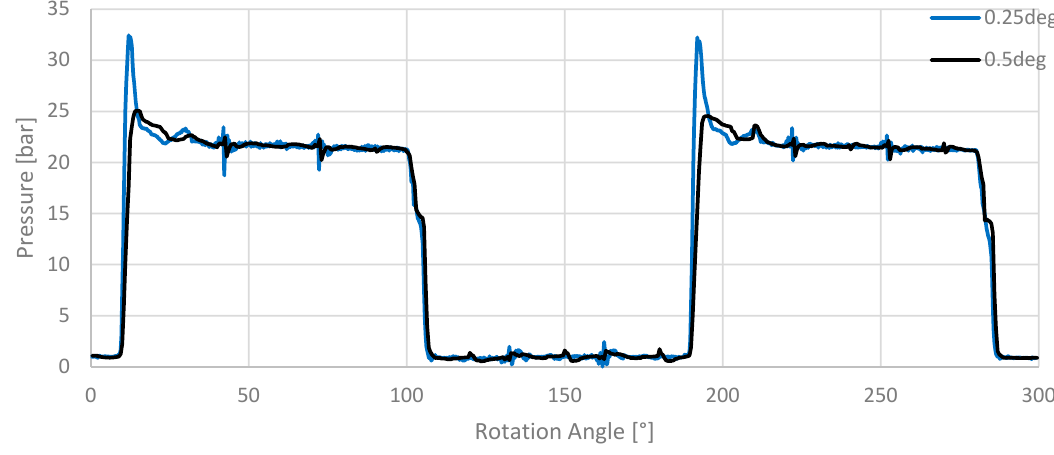
Figure 11. Influence of the angular resolution Δφ on the displacement chamber pressure.